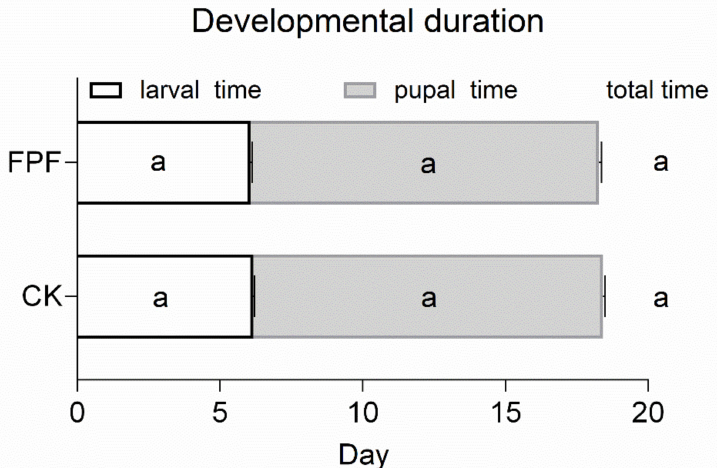
Figure 2. The effect of FPF on developmental duration. Values are mean ± SE ( n = 4). Bars with the same letter present not significant differences at p > 0.05 by the general linear modules. Larval development time = date of pupation − hatching date. Pupal development time = emergence date − date of pupation initiation. Total development time = emergence date − hatching